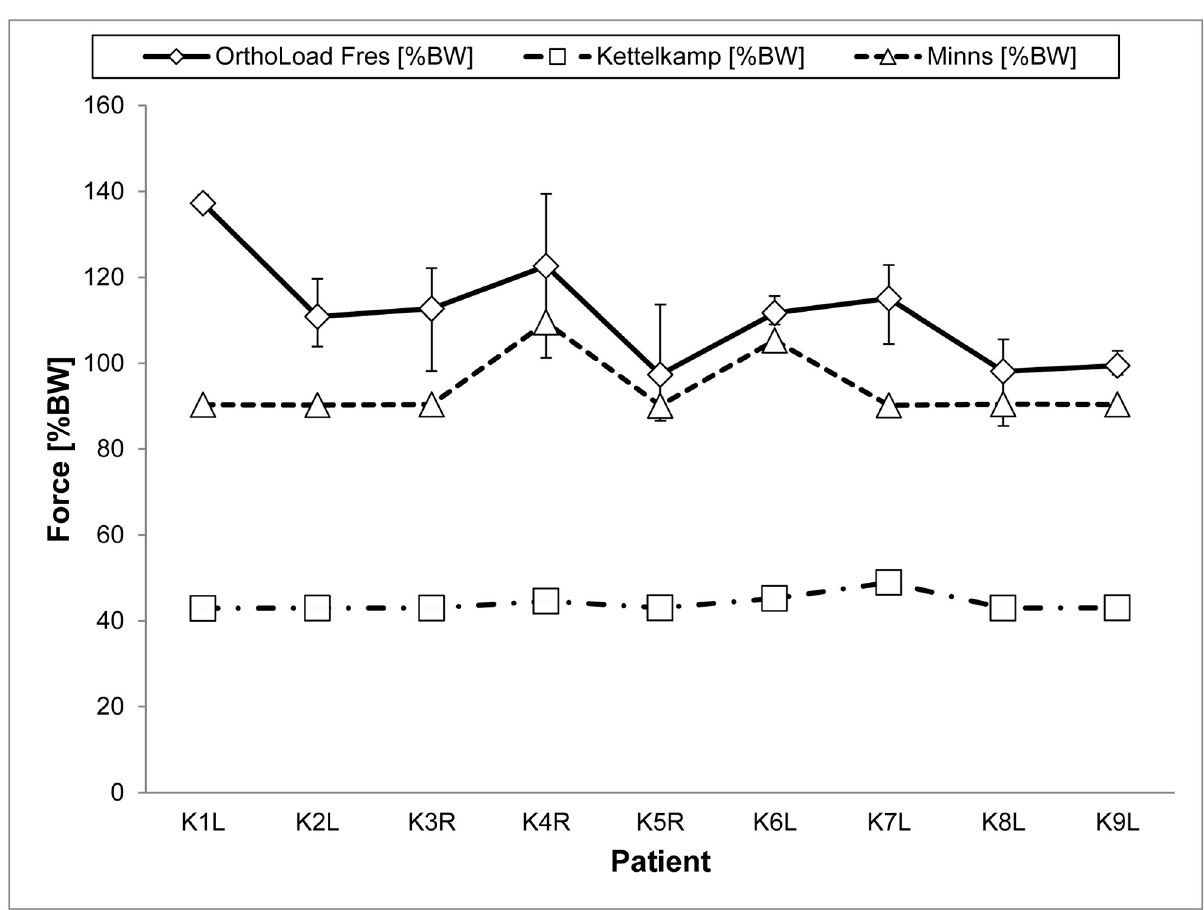
Fig 5. Resultant knee joint forces calculated for nine patients, based on the mathematical models of Kettelkamp and Minns with corresponding average in vivo force measurements for a two-leg stance. The error indicators demonstrate the minimum/maximum values. Forces in %BW.